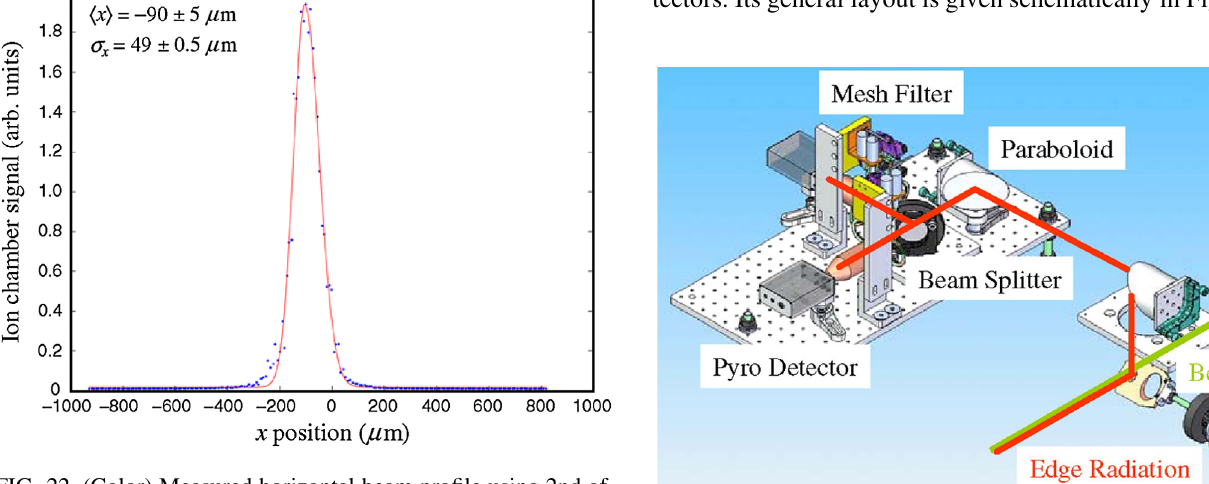
FIG. 22. (Color) Measured horizontal beam profile using 2nd of three wire scanners after BC1, showing a 49 - (cid:2) m rms size based on a Gaussian (red) fit. The signal is a fast ion chamber down- stream of the wire.